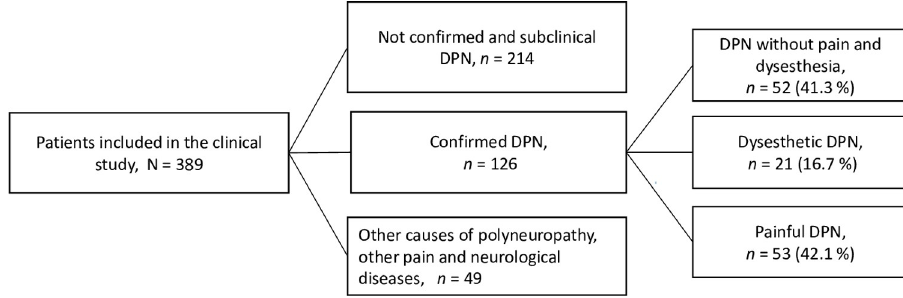
Fig 1. Flow diagram of patient inclusion and diagnosis of confirmed DPN according to the Toronto criteria [22] and the NeuPSIG grading of neuropathic pain [36]. For a detailed description of the recruitment, please refer to [19].